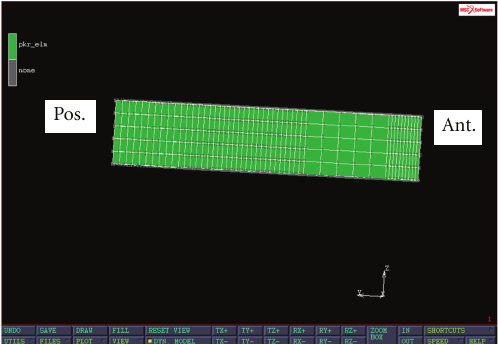
Figure 3: Sagittal view of a modified PKR with a frontal flange design. Red lines in the FE model are RBE2 nodal ties representing a frontal flange.